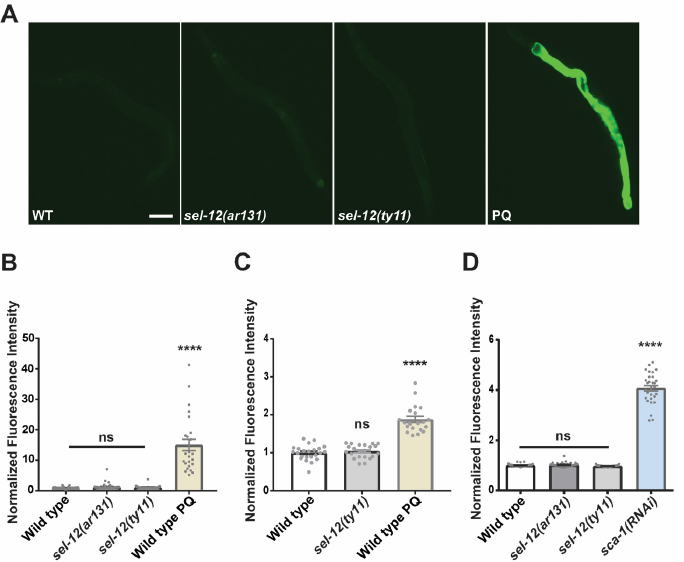
Figure 2. SEL-12/presenilin loss does not induce the mitochondrial unfolded response. ( A ) Repre- sentative images (scale bar = 0.1 mm) of GFP fluorescence intensity hsp-6p:: GFP transgenic animals as a reporter for UPR mt . ( B , C ) Quantification of GFP fluorescence intensity in hsp-6p:: GFP ( B ) or in hsp-60p:: GFP ( C ) transgenic animals as reporters for the UPR mt . Paraquat (PQ) was used to induce mitochondrial ROS as a positive control. ( D ) Quantification of GFP fluorescence intensity in hsp- 4p:: GFP transgenic animals as a reporter for UPR ER . sca-1(RNAi) was used as a positive control to knock down expression of the sarco-endoplasmic reticulum calcium ATPase (SERCA) to induce an ER stress response. (n ≥ 20). ns p > 0.05, **** p < 0.0001 using one-way ( B , C ) with Kruskal-Wallis multiple comparison test. Comparisons are made to wild type unless otherwise indicated. Error bars indicate mean +/ − SEM.